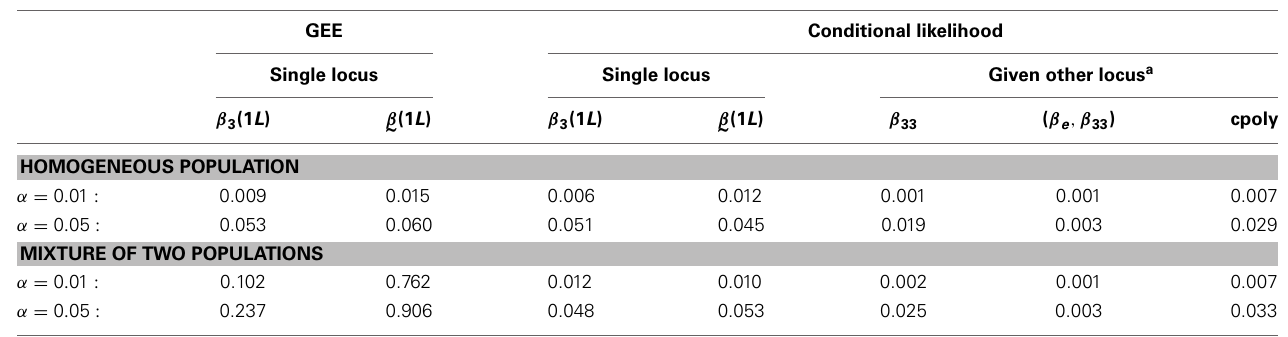
Table 2 | Estimations of Type I error on 1000 replicate samples of 100